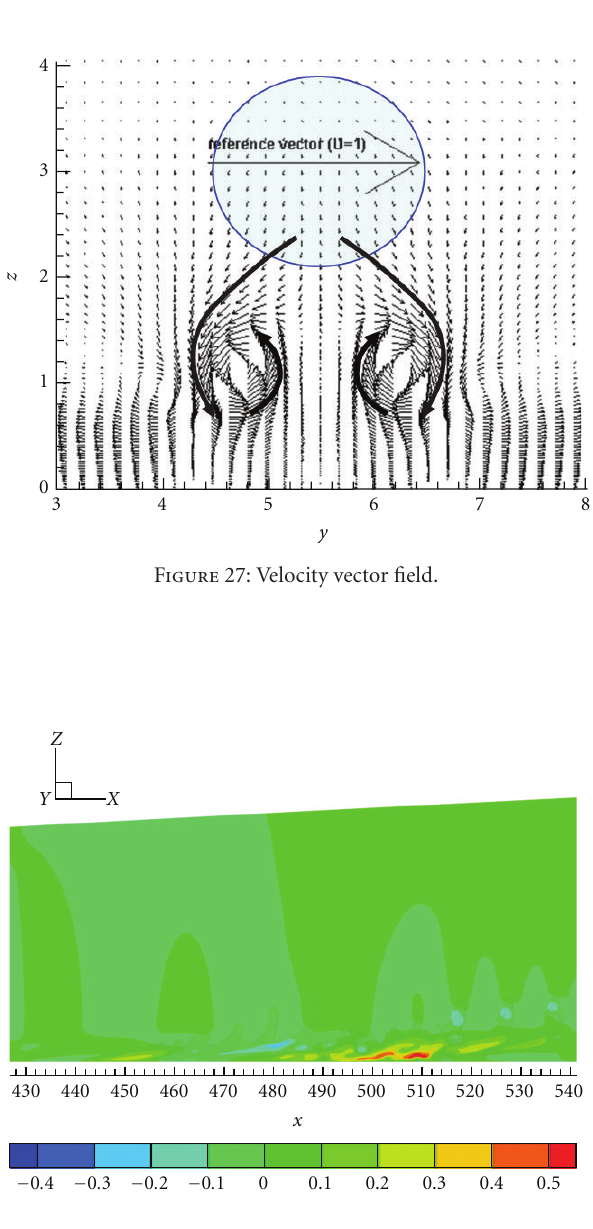
Figure 28: Vorticity distribution at x = 508 . 633.